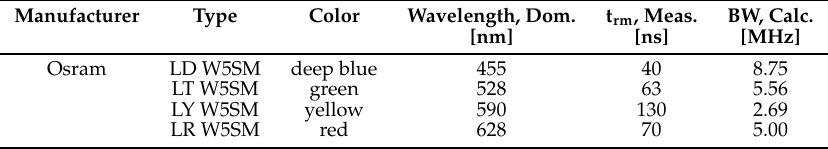
Table 3. Measured values for 10% to 90% rise time t rm of investigated LEDs used as emitter.